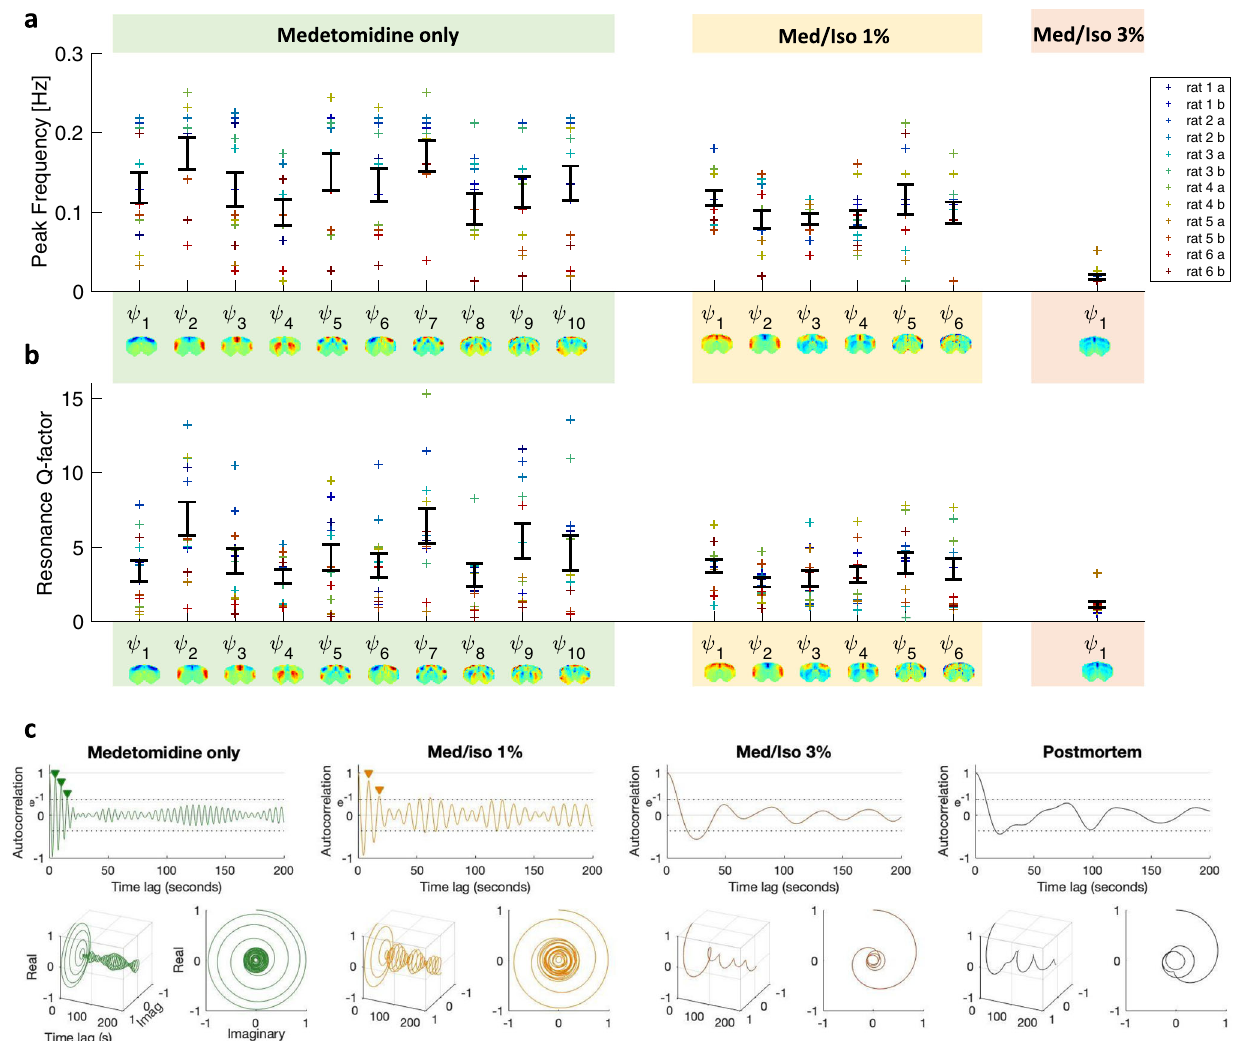
Fig. 7 | Principal components oscillate at higher frequencies and with less damping under medetomidine. The temporal signatures associated with the principal components detected in each condition are characterized in terms of peak frequency ( a ) and Q -factor ( b ) for each of the s =12 scans in each condition (2scans per rat). Error bars represent the mean±standard error across scans. c To illustrate the stability of the oscillations, the autocorrelation functions of the